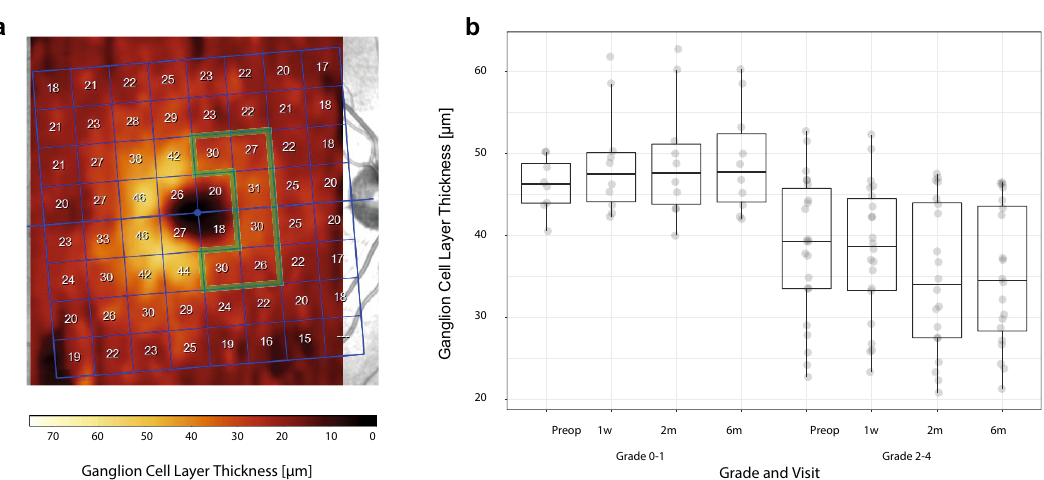
Figure 2. Example from a preoperative OCT examination of patient #8. The limited field (inside the green line) represents the nasal half of the fovea used for the quantification of the ganglion cell layer (GCL) thickness. The GCL thickness is color-coded and clearly shows hemifield asymmetry related to the chiasmatic syndrome ( a ). The distribution of GCL thickness was significantly different between patients with the grade of compression 0–1 and 2–4 (p = 0.024 × 10 –6 ). For the description of the boxplot parameters, see the legend of Fig. 1b ( b